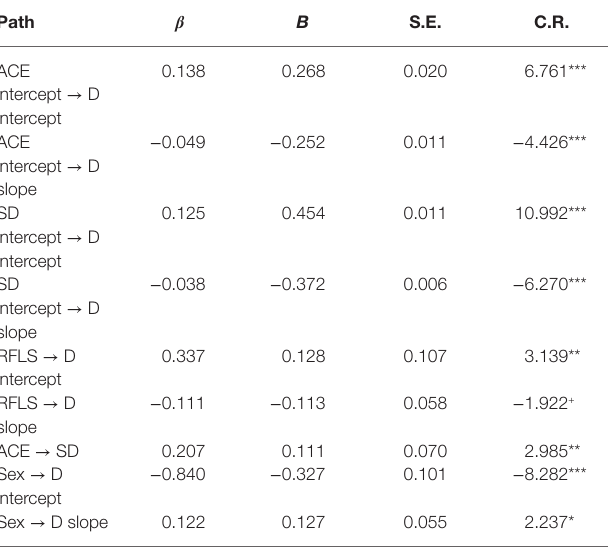
TABLE 3 | Path coefficients of multivariate latent growth modeling